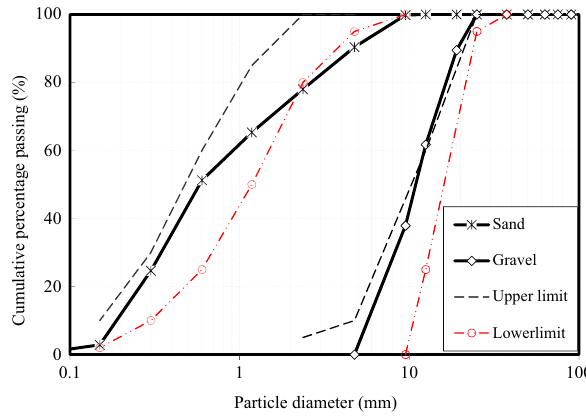
Figure 1: Grading curve of used materials ( gravel and sand ) .